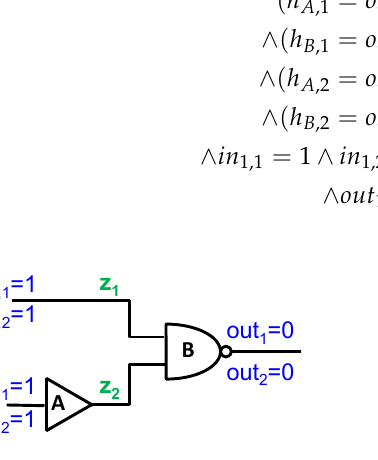
Figure 2. An example of a system with two